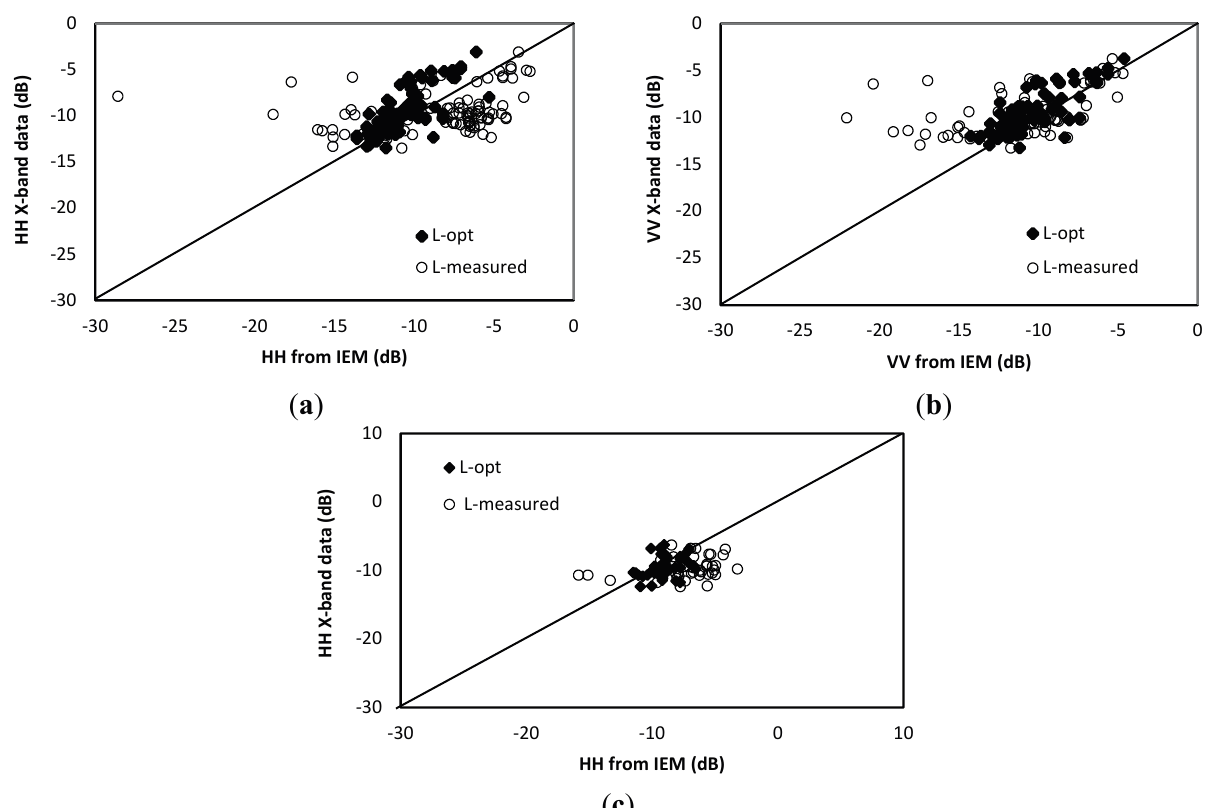
Figure 11. Comparison between X-band radar signals and Baghdadi-calibrated IEM [36] simulations: ( a ) HH polarization; 36° incidence angle; ( b ) VV polarization, 36° incidence; ( c ) HH polarization, 26° incidence. Table 3. Main statistical indexes (Bias and RMSE) for the IEM model, Dubois model, and the IEM model calibrated using Lopt, described by Baghdadi et al. [36], in the HH and VV